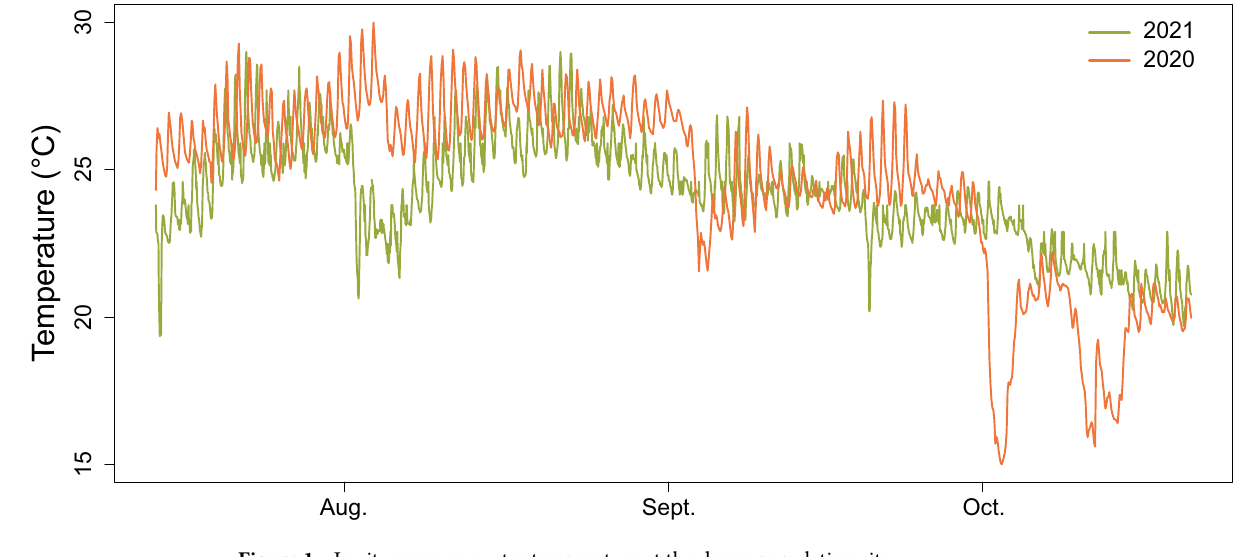
Figure 1. In situ mean seawater temperature at the donor population site.